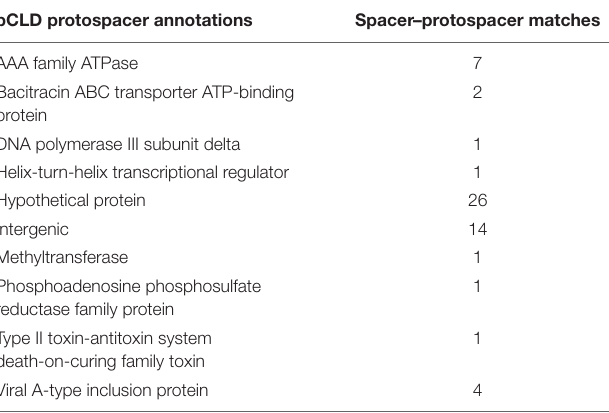
TABLE 2 | Annotations associated with pCLD protospacers matched to spacers derived from 44 G1 C. botulinum and C. sporogenes strains ( Figure 4C ). pCLD protospacer annotations Spacer–protospacer matches